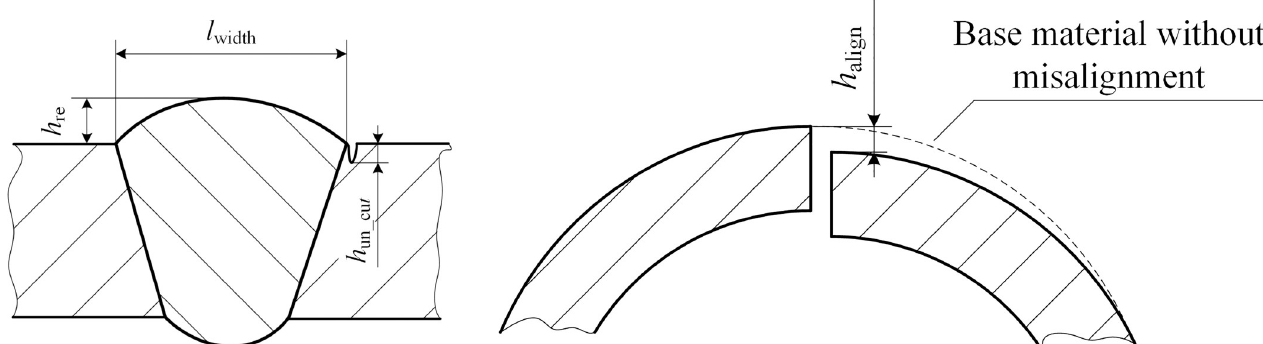
Fig 3. Schematic diagram of parameter definition of butt weld 4. (a) Definition of weld reinforcement, width, and undercut. (b) Definition of weld misalignment.